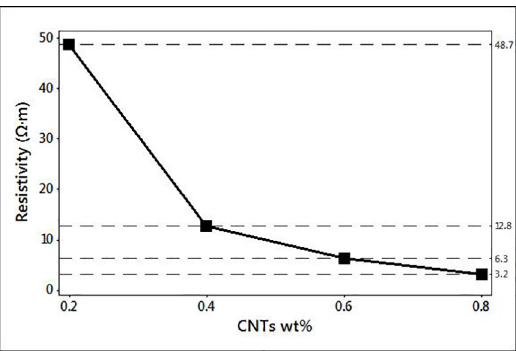
Figure 6. Composites resistivity behavior according to CNTs addition. Energy dispersion for 0.005 kgf indentation can be